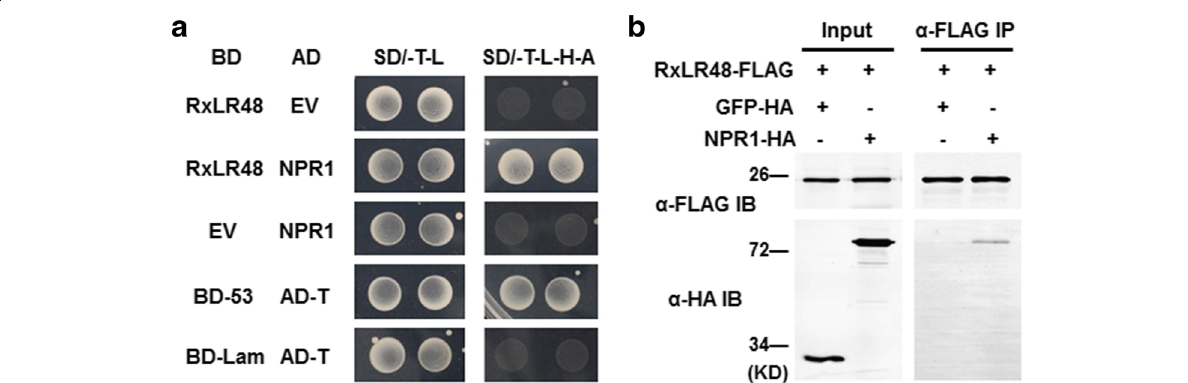
Fig. 1 RxLR48 interacts with NPR1. a Interaction between RxLR48 and NPR1 in yeast. RxLR48 was cloned into bait plasmid pGBKT7 (BD) and NPR1 was cloned into prey plasmid pGADT7 (AD), respectively. Combination of BD-53 and AD-T was used as a positive control while BD-Lam and AD-T as a negative control. Yeast transformants were grown on selective medium (SD) lacking Tryptophan (T) and Leucine (L) and selected on SD lacking Tryptophan (T), Leucine (L), Histidine (H) and Adenine (A). The plates were photographed at 3 days after inoculation. b Interaction between RxLR48 and NPR1 in Arabidopsis . RxLR48-FLAG and NPR1-HA were transiently co-expressed in Arabidopsis protoplasts. RxLR48 together with GFP was used as a negative control. Total proteins were extracted, followed by immunoprecipitation with an α -FLAG antibody ( α -FLAG IP). Input and the bound proteins were detected via immunoblot using α -FLAG and α -HA antibodies, respectively